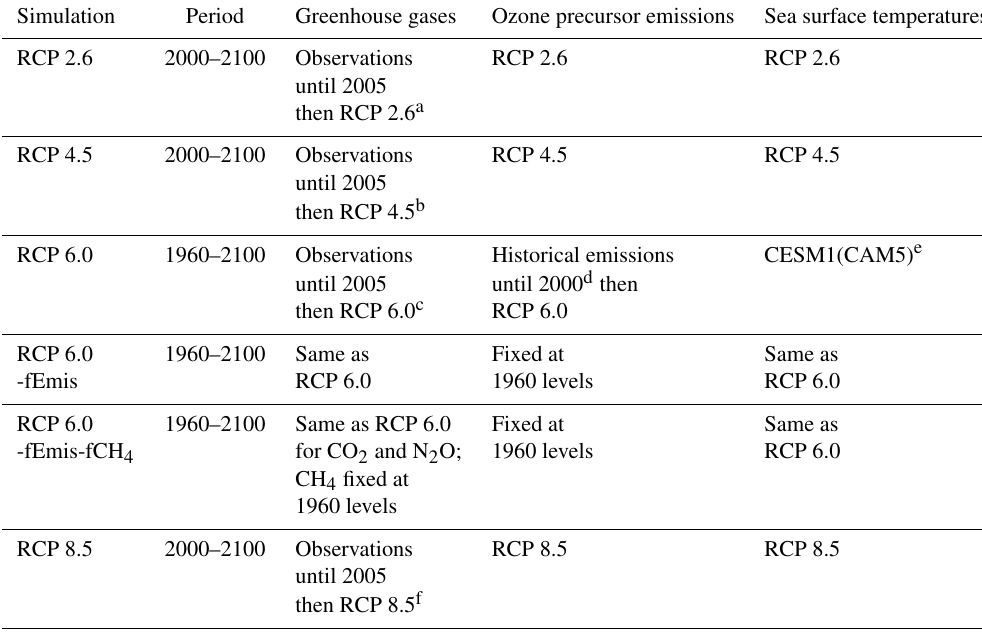
Table 1. Summary of boundary conditions used for the SOCOL v.3 CCM